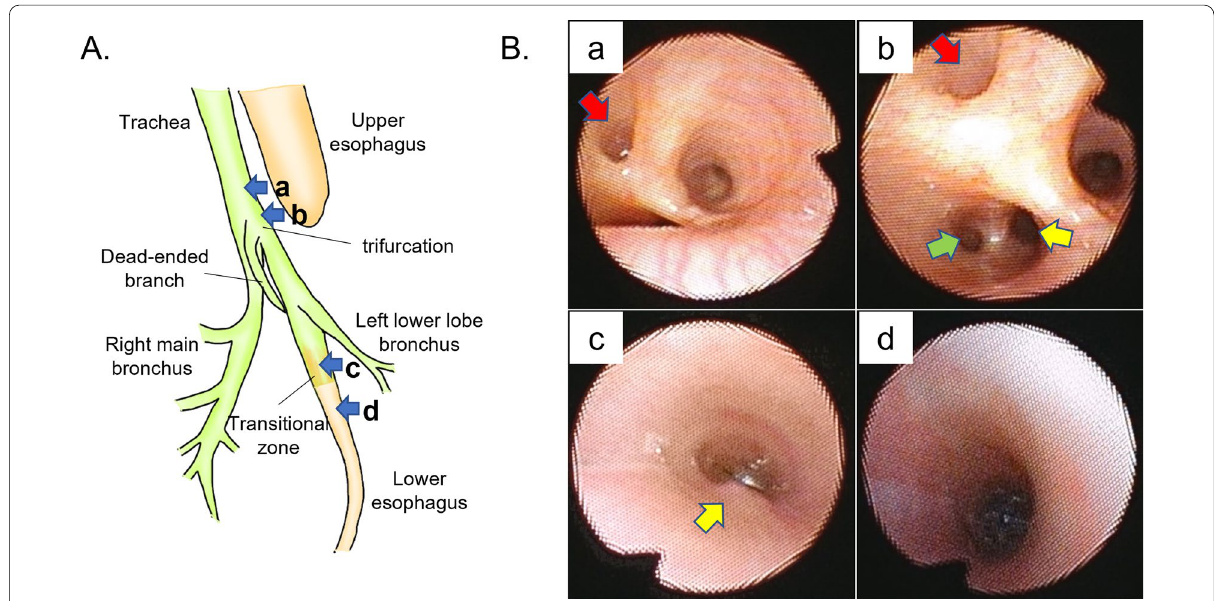
Fig. 3 A The scheme represents the airway (green) and esophagus (yellow). The lowercase letters in the figure correspond to each bronchoscopy finding in B . B The trachea was trifurcated in three directions. The left branch was blind-ended (red arrow) ( a ). The dorsal branch was cartilaginous and bifurcated into the left inferior lobe bronchus (green arrow) and lower esophagus (yellow arrow) ( b ). Cartilage tissue was observed in the lower esophagus, presenting a bronchial-like appearance ( c ). A normal esophageal wall appeared distally ( d )